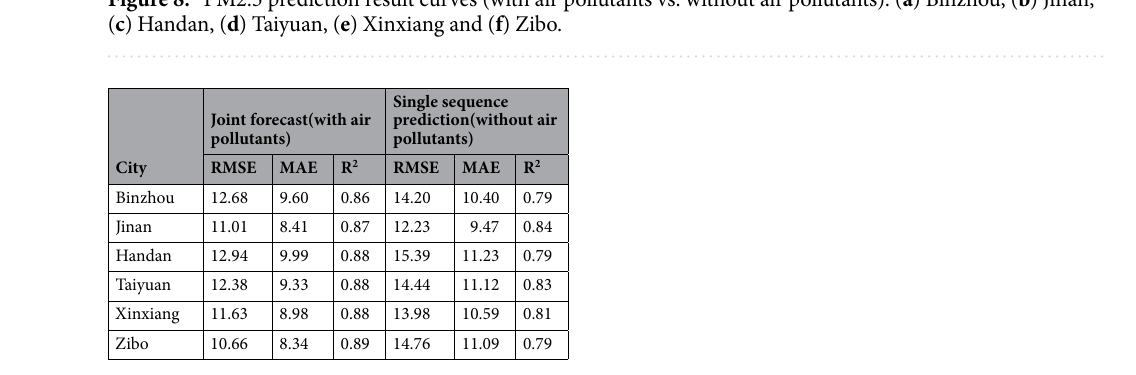
Table 5. Comparison of the accuracy of prediction results before and after the introduction of air pollutants.